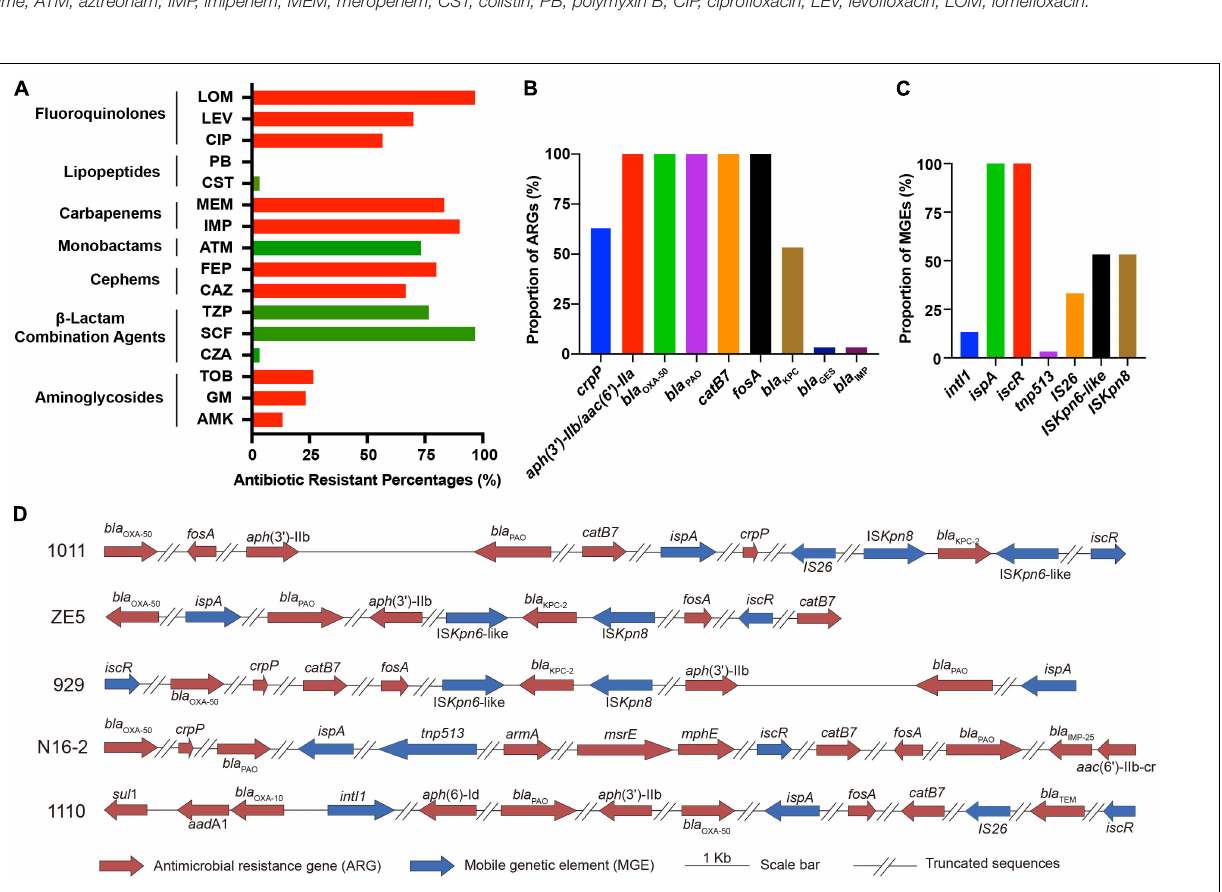
Frontiers in Microbiology |